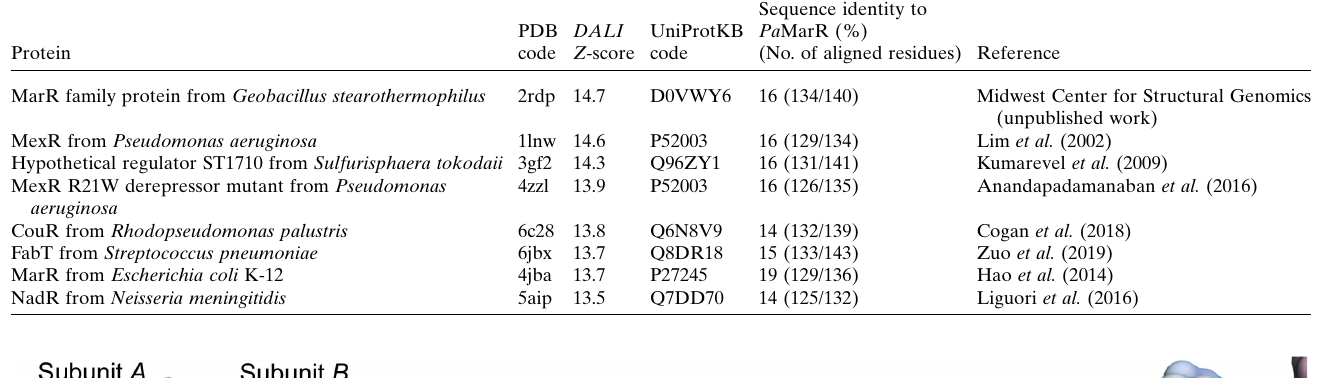
[Fig. 4( b )]. Given that helices (cid:3) 1 and (cid:3) 7 are associated with the formation of the cavity and the interface between the subunits, these findings suggest that the spatial arrangements of the (cid:3) 1 and (cid:3) 7 helices may affect the strength of the dimer and the formation of a cavity specific to temperature-depen- dent MarR proteins. Hence, the shape of each cavity in the Table 2 Structural homologue search results for Pa MarR from a DALI search ( DaliLite server).